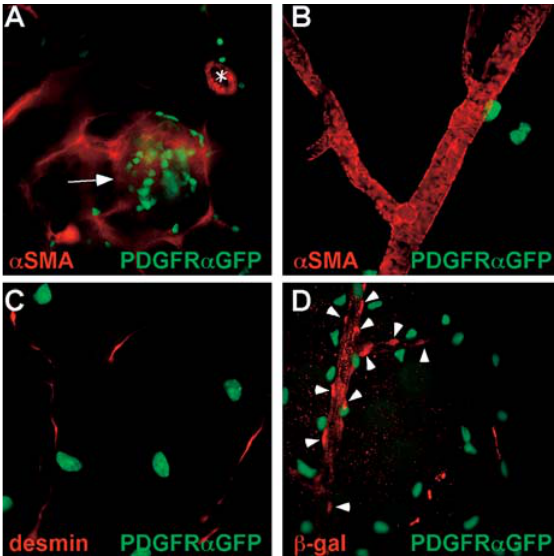
Figure 3. Tissue Localization of V/P Cell Markers and PDGFR a Expression Tissue preparations from P21 PDGFR a GFP/ þ ;PDGFR b F5/F5 mutant mouse. Immunofluorescence was used to detect a SMA (A and B), desmin (C), b -galactosidase (D), and GFP expression for PDGFR a (A– D). (A) Kidney (200 l m vibratome section). The arrow indicates glomerulus. The asterisk indicates an arteriole. (B–D) Retina (whole- mount preparation). Arrowheads point to b -galactosidase-positive nuclei. DOI: 10.1371/journal.pbio.0000052.g003